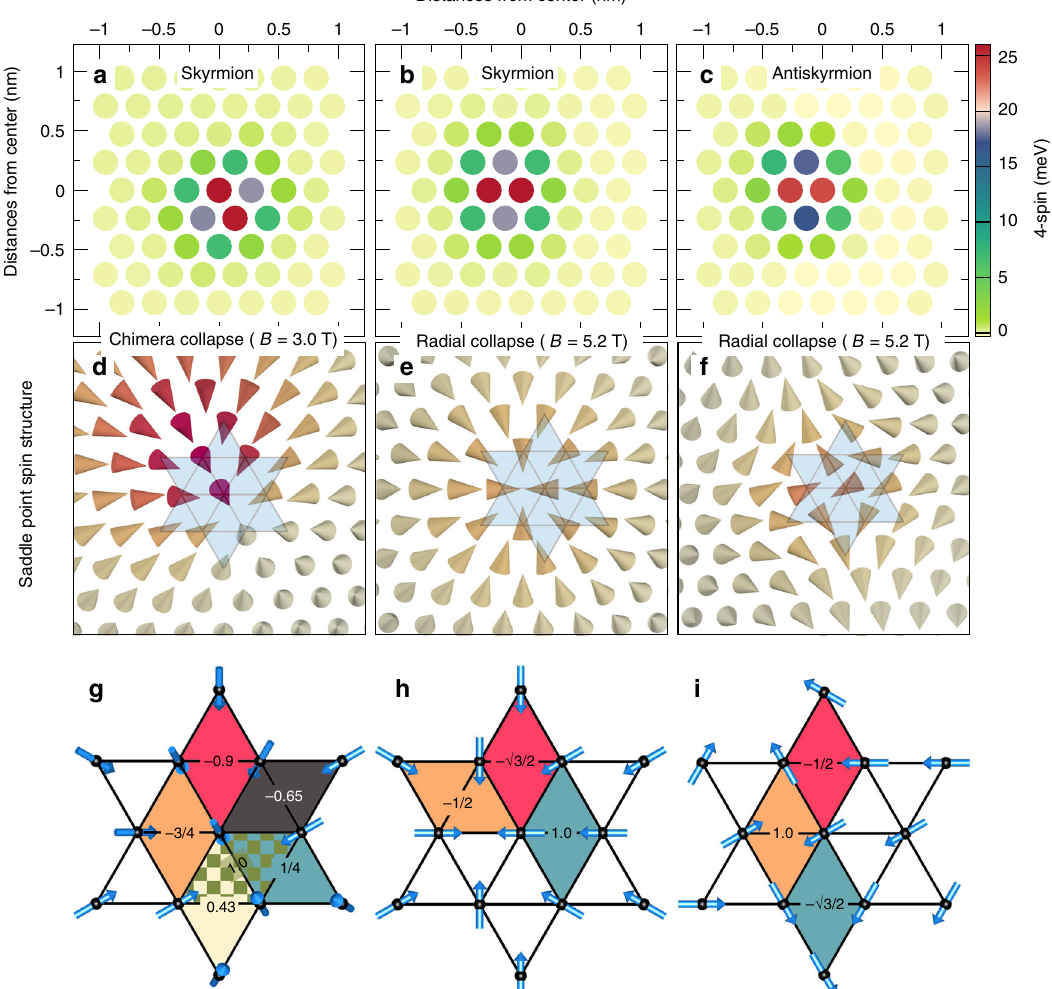
Fig. 4 Four-site four spin energy at the saddle points of Pd/Fe/Rh(111). a – c Atomic-site resolved energy contribution of the four-site four spin interaction at the saddle points of the minimum energy paths of Fig. 3b, e, h, i.e., for the chimera skyrmion collapse, the radial skyrmion collapse and the radial antiskyrmion collapse. Energies are given with respect to the initial state. d – f Saddle point spin structures of Fig. 3b, e, h. g – i Spin structure around the core spin at the origin, i.e., at (0, 0), of the saddle point is highlighted in d – f by the gray shaded star. Note that all spins of h , i are in-plane while most of the spins in g are not in-plane. The sign and the value of the four-site four spin interaction (4-spin) are shown for different